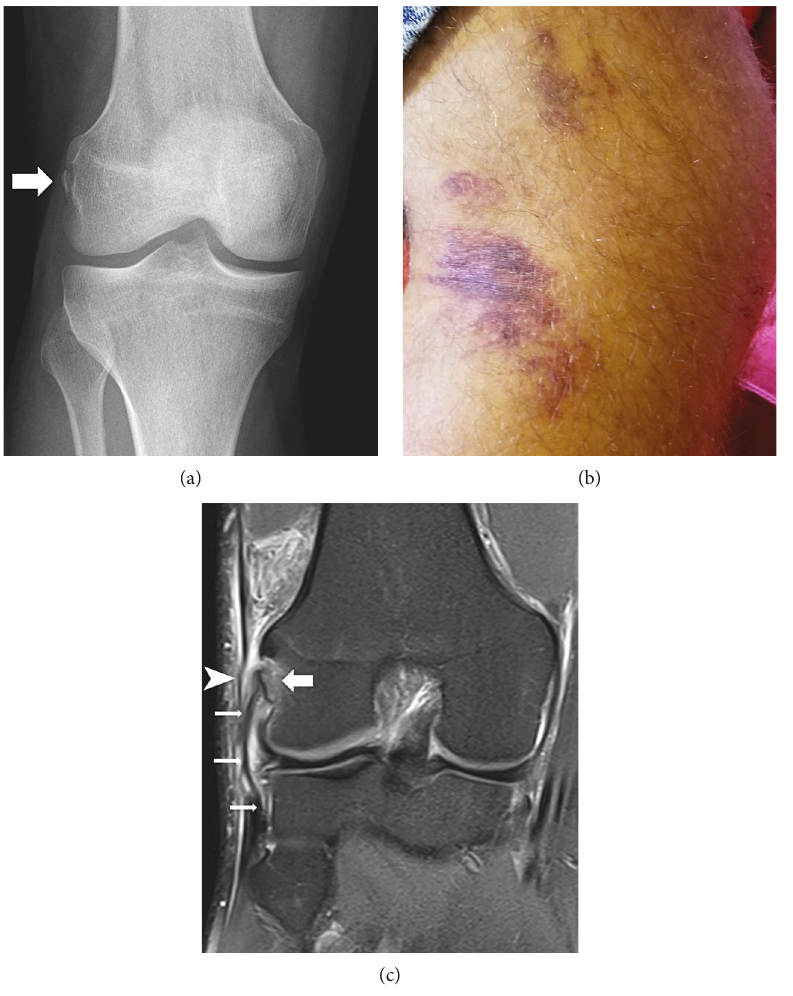
Figure 1: Patient case 1. (a) AP right knee X-ray at day 1 showing the avulsion fracture of the femoral insertion of the LCL (white arrow). (b) Clinical appearance at 2 weeks showing bruises over lateral aspect of the right knee. (c) Proton density coronal MRI of the right knee at day 3 showing a wavy though intact LCL (small arrows) attached to the avulsed bony fragment of the femoral insertion (large arrow). The iliotibial band (arrowhead) lies immediately super fi cial to the proximal